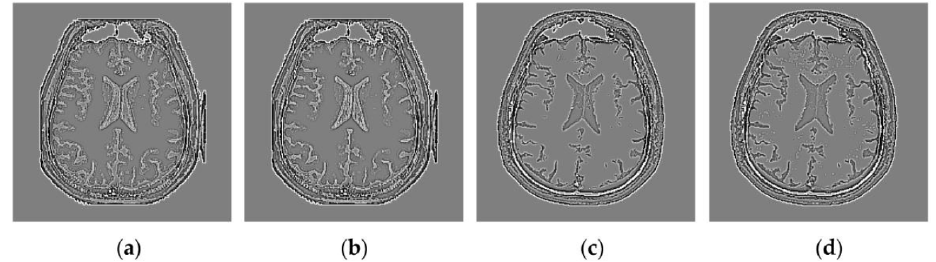
Figure 5. The Weber local descriptor (WLD) for the firing mapping images (FMIs) shown in Figure 4: ( a ) the WLD for Figure 4c; ( b ) the WLD for Figure 4d; ( c ) the WLD for Figure 4g; and ( d ) the WLD for Figure 4h.